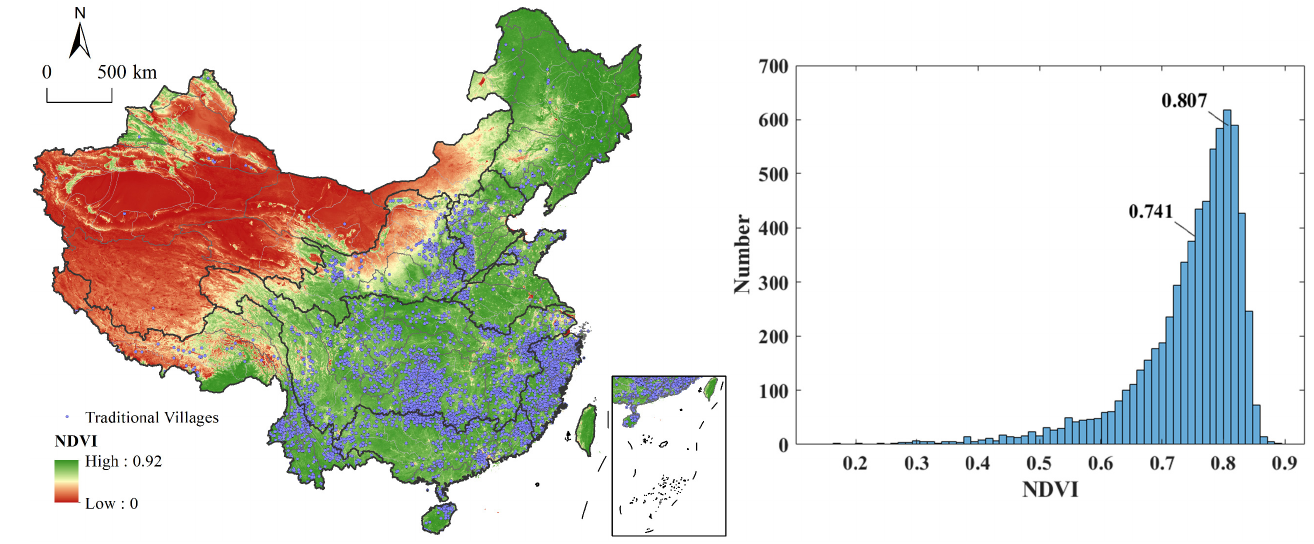
Figure 13. Relationships between traditional villages and NDVI in China.